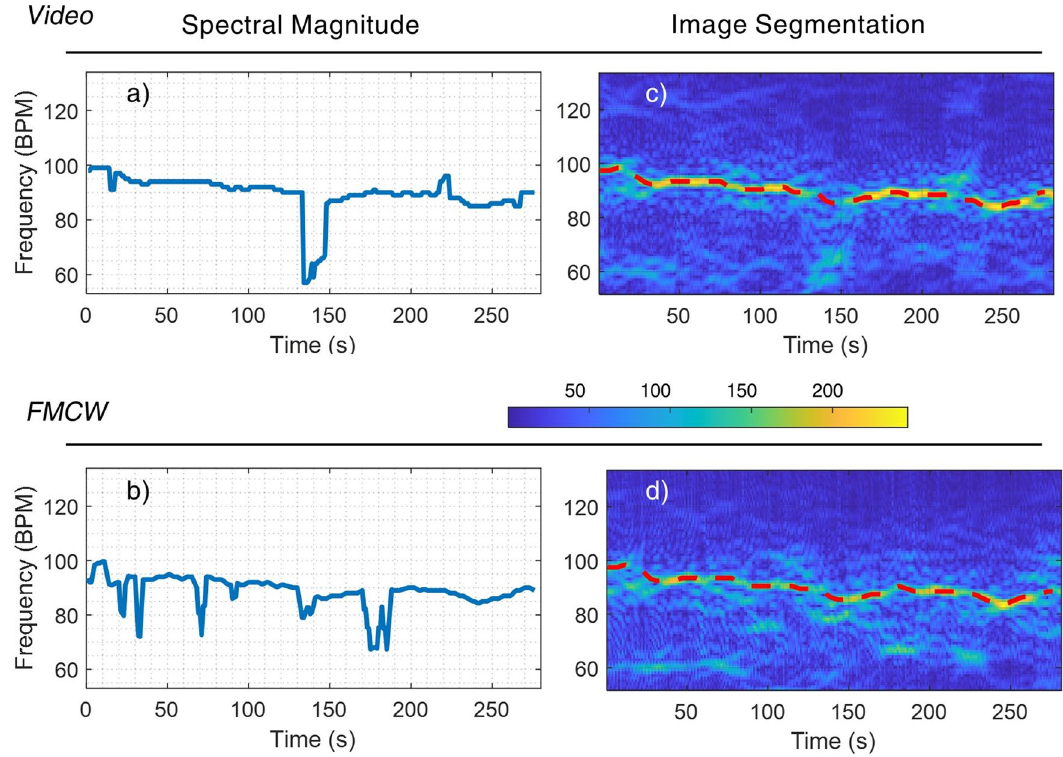
Figure 6. Simultaneous 5-min HR measurements using both the camera and FMCW radar. ( a ) and ( b ): HR estimation using the conventional largest spectral magnitude method. ( c )–( d ): The joint STFT spectrograms, where the red dashed lines indicate the HR readings estimated using the image segmentation method.